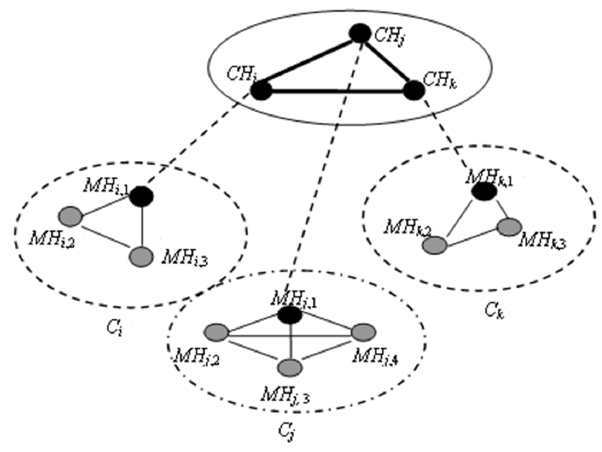
Figure 1. Multi-frequency hierarchy topological structure.